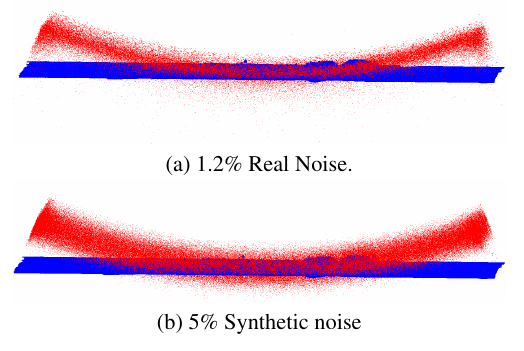
Figure 7: GM-Simulation vs Real data; red: noise points and blue: regular points